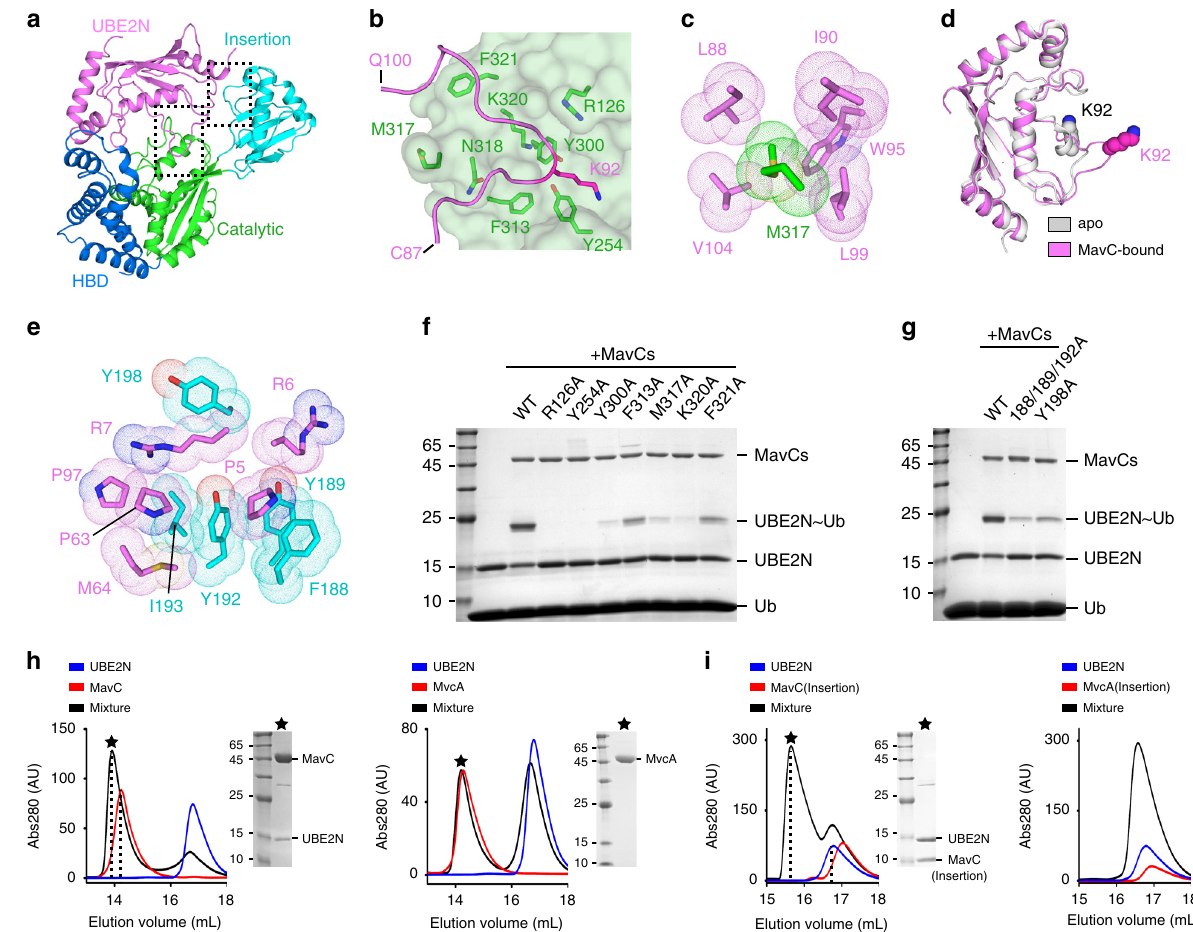
Fig. 2 Interactions between MavC and UBE2N. a Overall view of UBE2N – Catalytic and UBE2N – Insertion interacting surfaces, with the same color code as in Fig. 1a. b The aa 87 – 100 loop region of UBE2N (cartoon; purple) binds within a critical groove of MavC Catalytic domain (surface; green). c Detailed hydrophobic interactions between MavC-M317 (green) and the residues from UBE2N (purple). d Conformational changes of UBE2N upon binding to MavC. The K92 residues were highlighted as spheres. e Detailed hydrophobic interactions between MavC Insertion domain (cyan) and UBE2N (purple). f , g In vitro ubiquitination reactions for various MavC mutants in both Catalytic ( f ) and Insertion ( g ) domains. The reaction mixtures were subjected to SDS-PAGE and stained with Coomassie dye. h , i Elution pro fi les of SEC runs on Superdex 200 10/300 column to test binding of UBE2N with MavC/MvcA ( h ) or their isolated Insertion domains ( i ). Note that only MavC or MavC – Insertion, but not MvcA or MvcA – Insertion, has a considerable shift in elution volume upon binding to UBE2N. Black asterisks indicate the fractions analyzed by SDS-PAGE. Source data are provided as a Source Data fi le. Experiments in f – i were repeated independently three times with similar